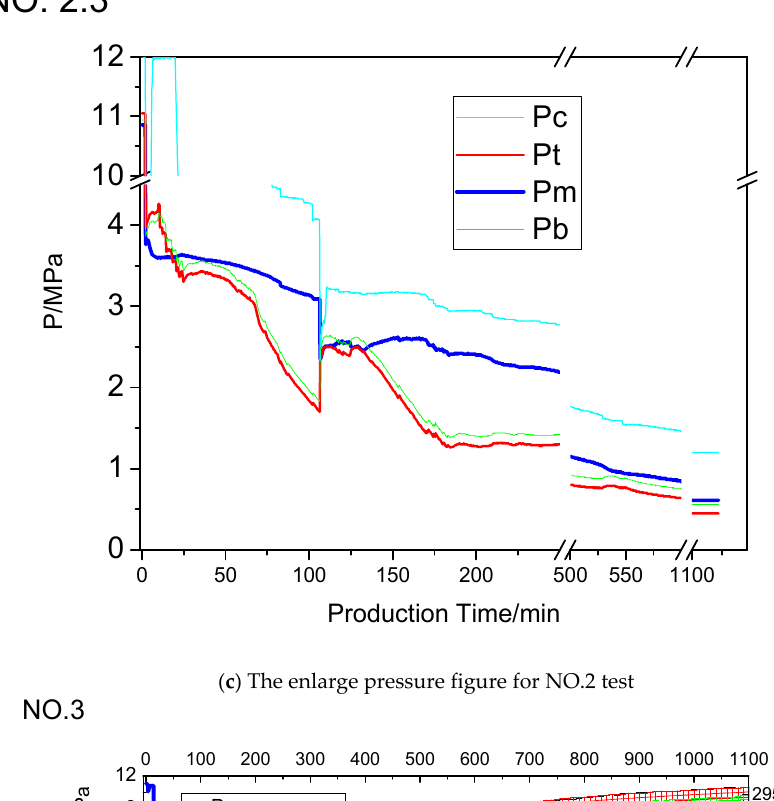
( c ) The enlarge pressure figure for NO.2 test